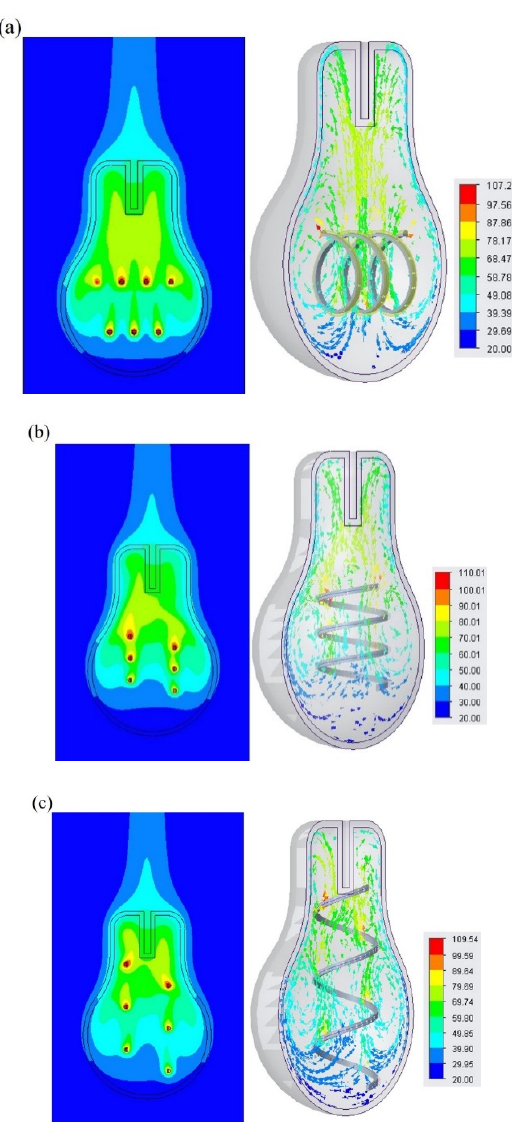
Figure 7. The cross-section temperature distribution and the gas flow path of three different filament arrangements ( a )–( c ) of LED bulbs. arrangements ( a – c ) of LED